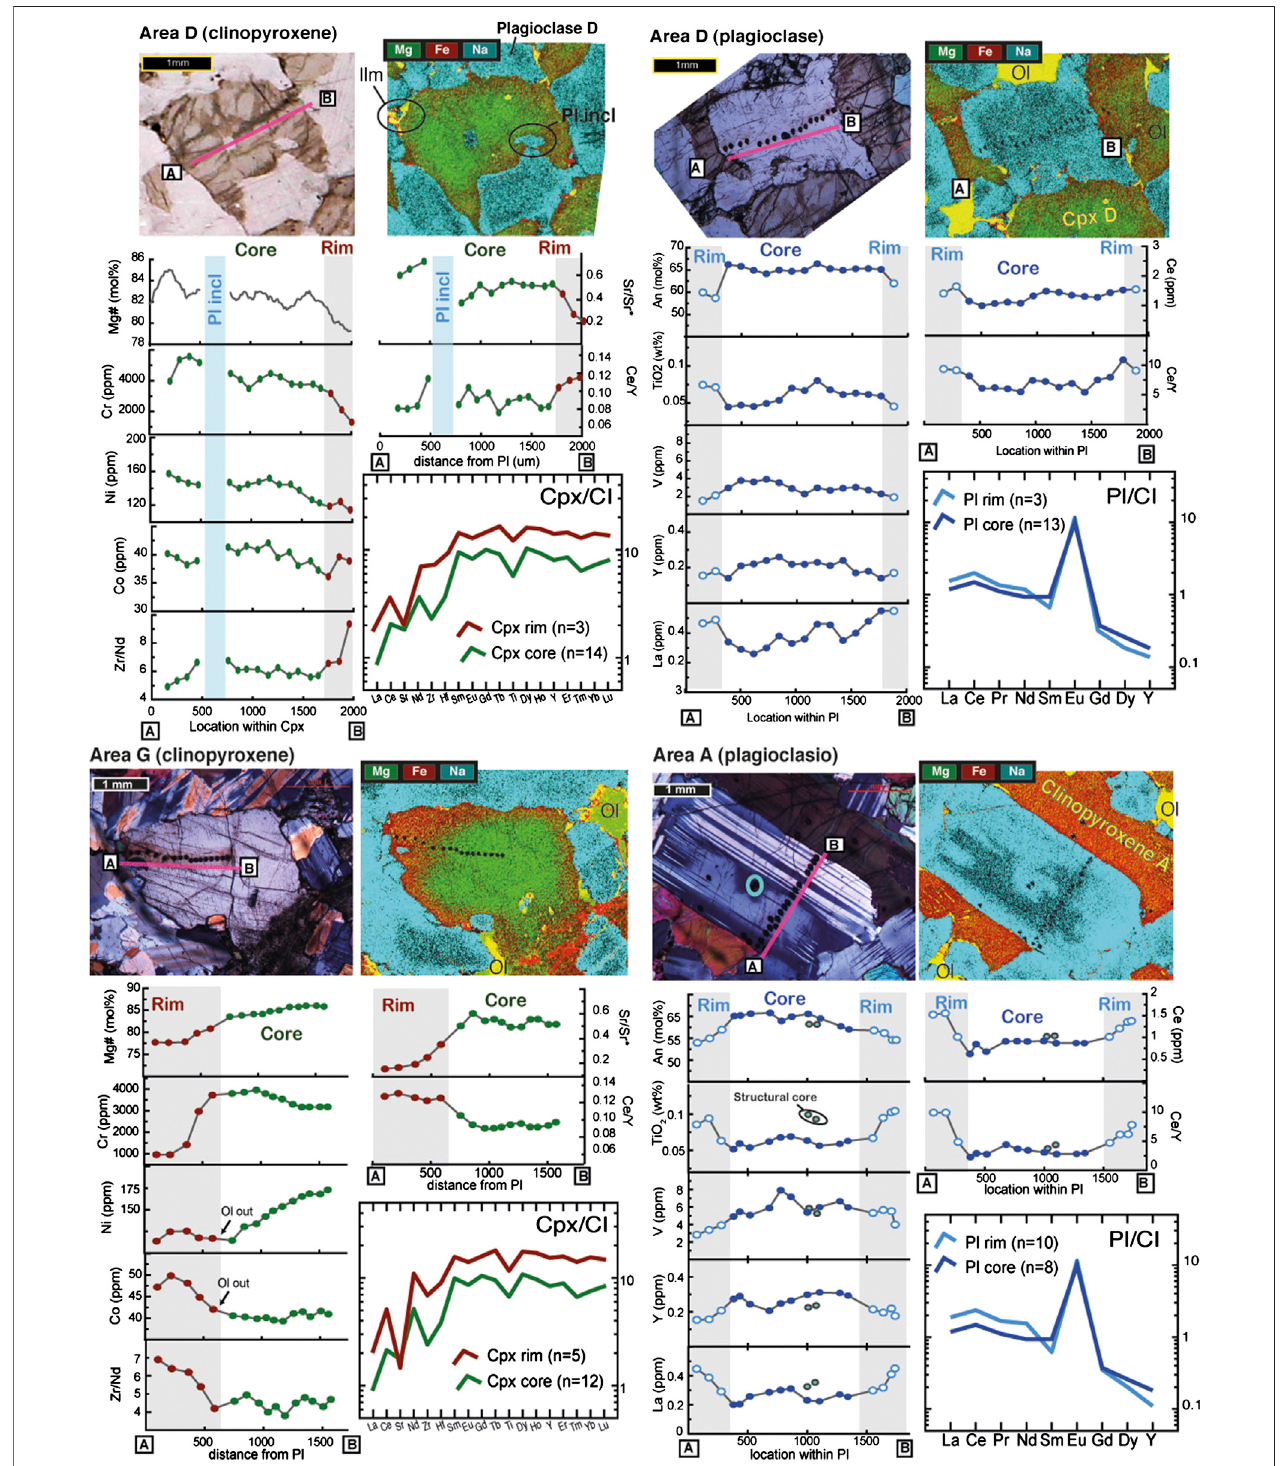
FIGURE 4 | Plagioclase and clinopyroxene geochemical pro fi les of grains selected in areas A and G (see Supplementary Material for the complete dataset). Plagioclase-Rim and clinopyroxene-Rim are de fi ned on the optical and chemical zoning and underlined by a grey background (see text). Photomicrographs show the locations of each point analysis. The CI normalized incompatible trace element patterns of average analyses of Pl- and Cpx-Core (red) and Pl- and Cpx-Rim (green) are alsoshown.Thegeochemicalpro fi lesincludeAn(mol%),TiO 2 (wt%),V,Y,La,Ce(ppm)andCe/Yratioforplagioclase;Mg#(mol%),Cr,Ni,Co(ppm)andZr/Nd,Sr/ Sr* (cid:1) Sr N [ √ (Ce N xNd N )], Ce/Y ratios for clinopyroxene.